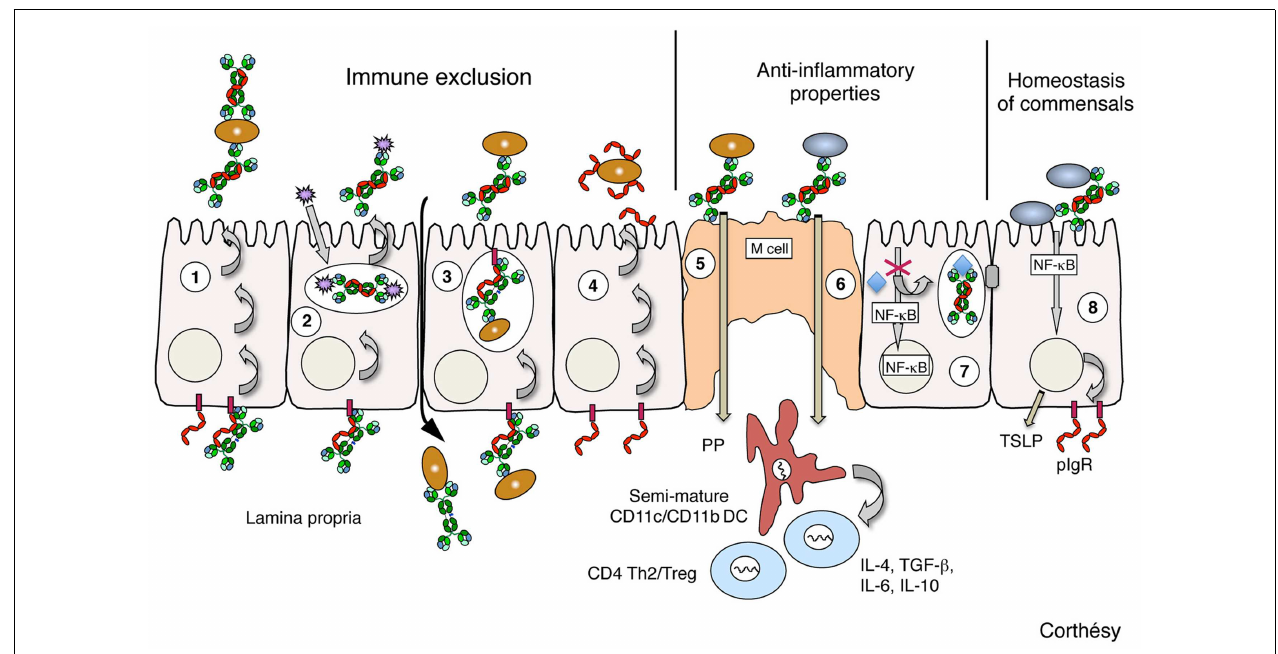
form of immune complexes with noxious antigens, presentation to naïveT cells in the PP and draining mesenteric lymph nodes (not drawn) results in the onset of attenuated,Th2-biased mucosal immune responses with concomitant quenching of inflammatory circuits. (6) Remarkably, the